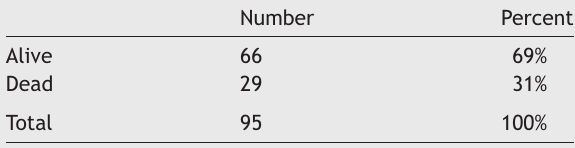
Frequency of deaths in all patients submitted to hematopoietic stem cell transplantation.